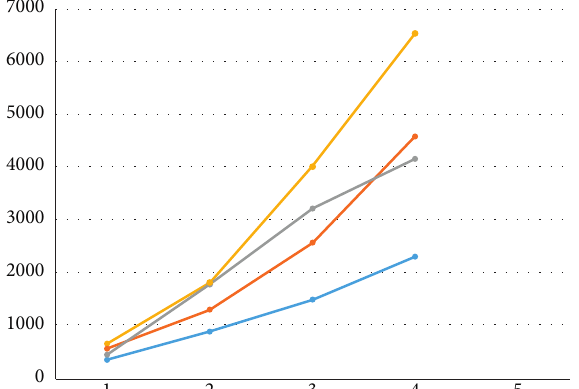
P n + D m graphs such as